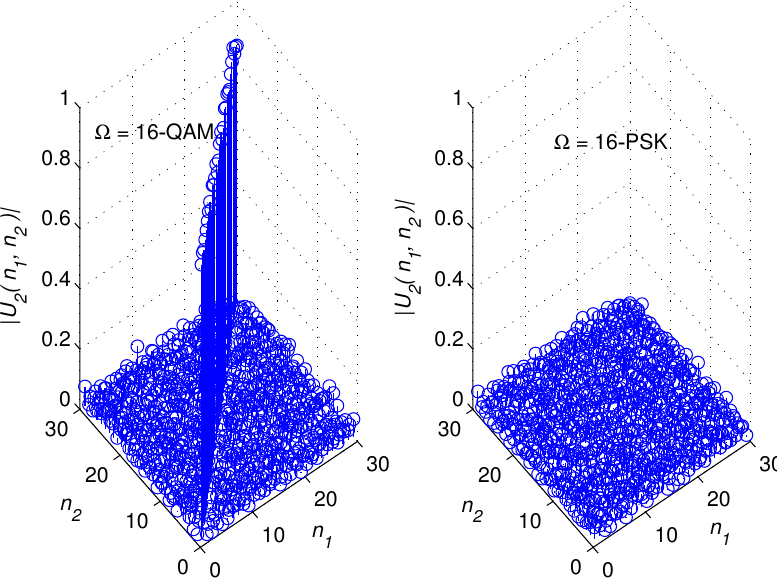
Figure 3. The magnitude of the second correlation function at the modulation forms of 16-QAM and